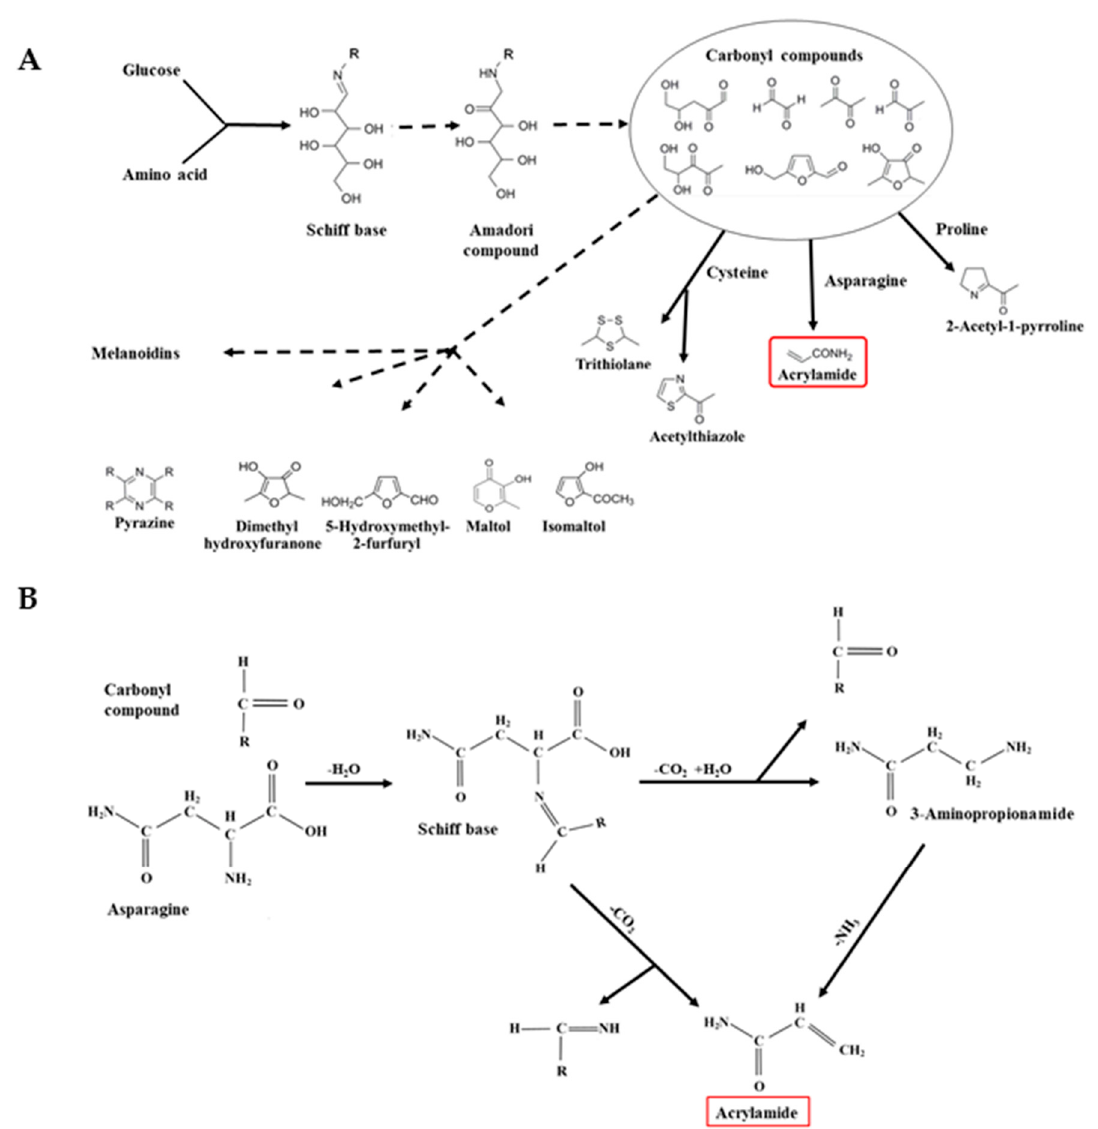
Figure 2. ( A ) Simple representation of the Maillard reaction, showing the Schiff base and Amadori compound formed from the reaction of glucose (an aldose) with free amino acids (fructose and other ketoses would form related Heynes compounds). Carbonyl compounds such as deoxyosones are formed by enolisation, deamination, dehydration, and fragmentation of Amadori and Heynes compounds, and react again with free amino acids to give a plethora of products, some of which are shown. ( B ) Formation of acrylamide by Strecker degradation of free asparagine [19].